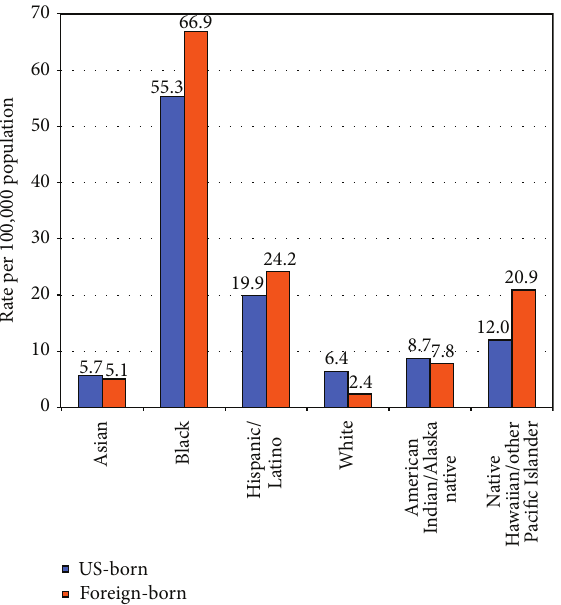
Figure 5: Rates of human immunodeficiency virus (HIV) diagnoses by race/ethnicity and nativity/immigrant status, 46 US states and 5 US territories, 2007–2010. Source: Prosser AT, Tang T, Hall HI. HIV in persons born outside the United States, 2007–2010, [17]. The relevant population denominator data are from the 2008–2010 American Community Survey. Estimated HIV numbers resulted from statistical adjustment that accounted for missing country of birth reporting delays and missing risk factor information, but not for incomplete